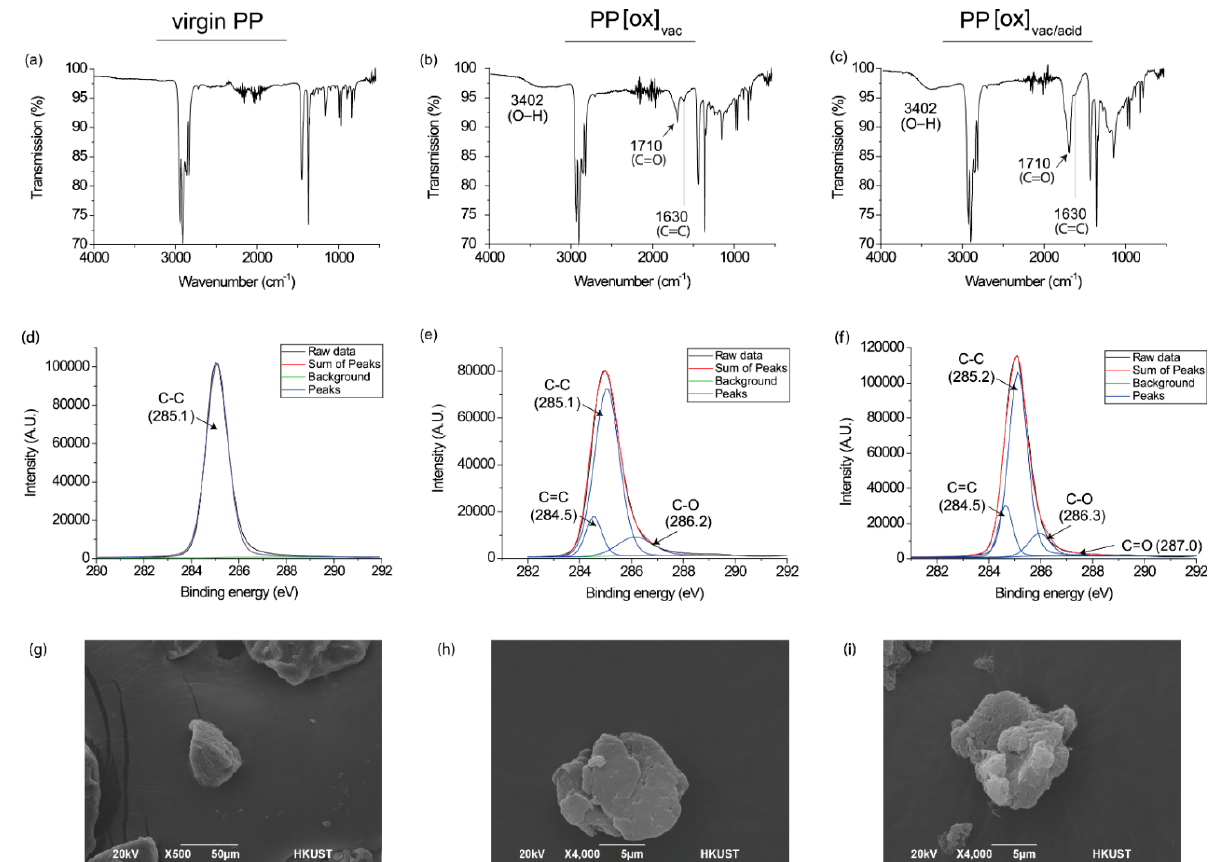
Figure 1. ( a – c ) FT-IR, ( d – f ) XPS, ( g – i ) SEM images of virgin PP, PP[Ox] vac , and PP[Ox] vac/acid .